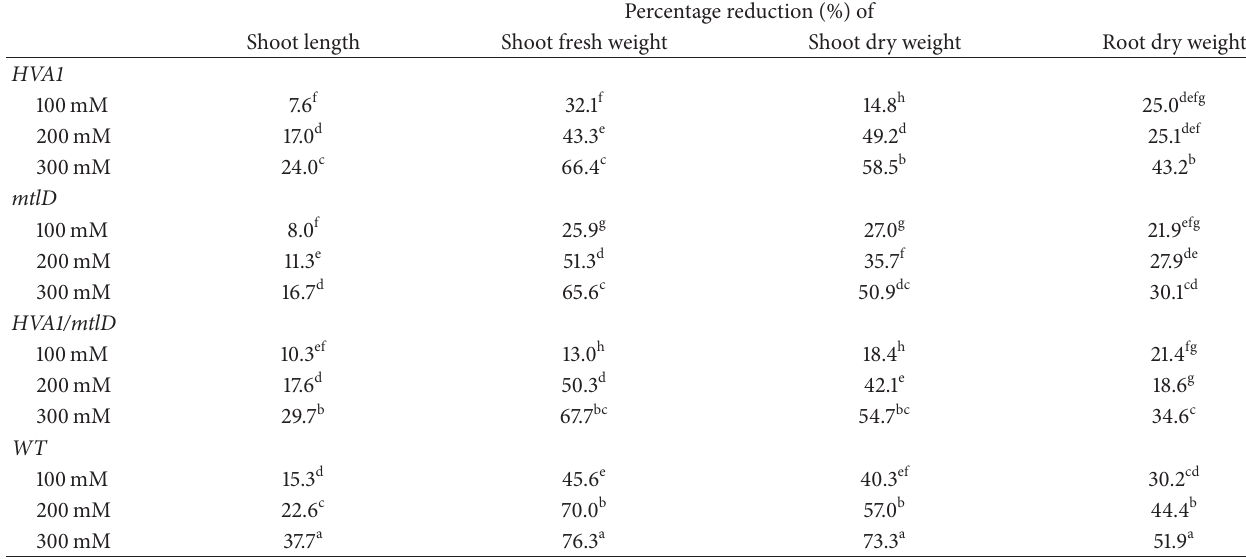
Table 2: Effects of salt treatments on shoot length, shoot fresh weight, and shoot and root dry weight of HVA1 , mtlD , and HVA1-mtlD T3 plants. Percentage reduction (%) of Shoot length Shoot fresh weight Shoot dry weight Root dry weight